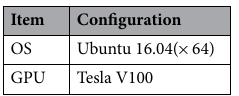
Table 2. Environment configuration.